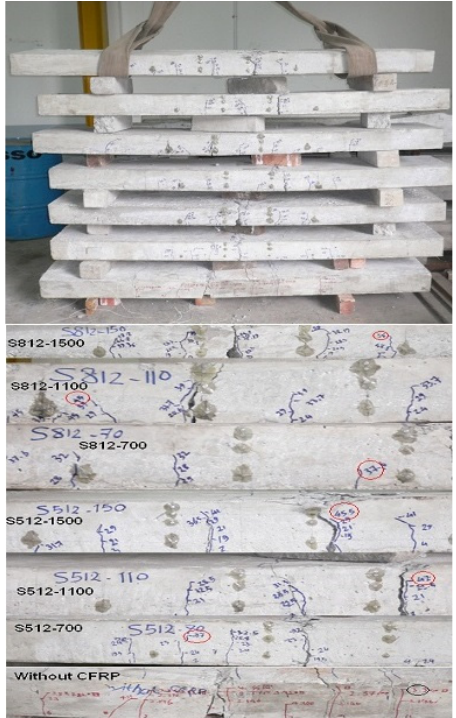
Figure 8. Crack pattern of RC slabs strengthened with CFRP under the four-point bending test.